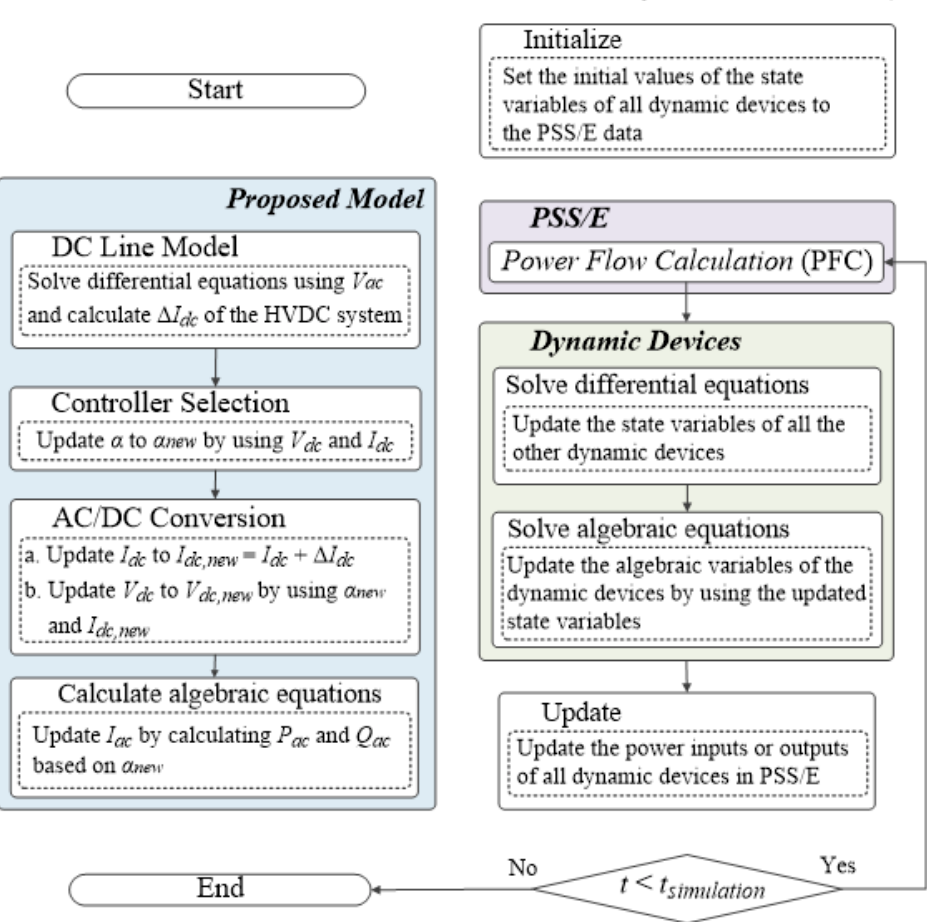
Figure 5. Flowchart of the proposed method for HVDC system modeling to enhance calculation of the DC voltages and current during the AC grid faults.